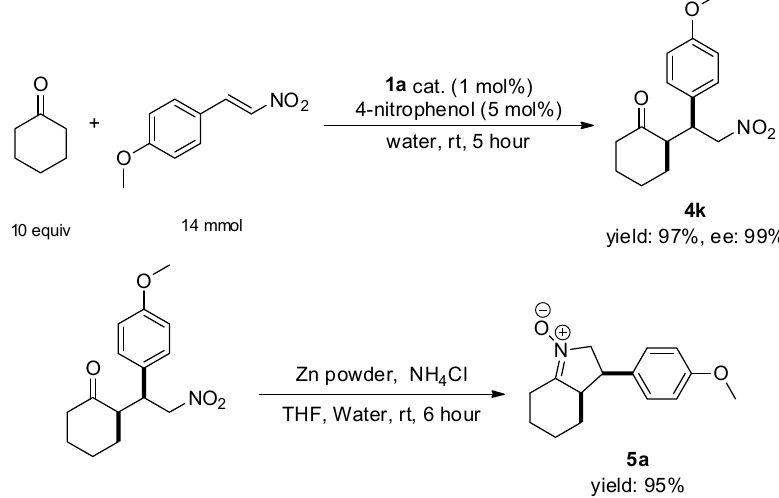
Figure 1. Proposed catalytic mechanism based on B3LYP/6-31G(d,p) calculations and the free en- ergy diagram of the ( R , R )-1,2-diphenylethylenediamine(DPEN)-thiourea-catalyzed enantioselective Michael reaction.